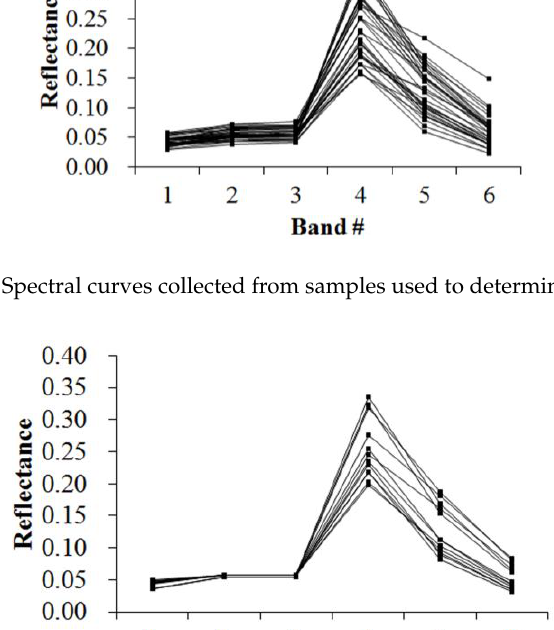
Figure 7. Spectral curves collected from samples used to determine Table 5. Table 5. Identification template 1 for forest class. Figure 8. Spectral curves collected from samples used to determine Table 6. Table 6. Identification template 2 for forest class.